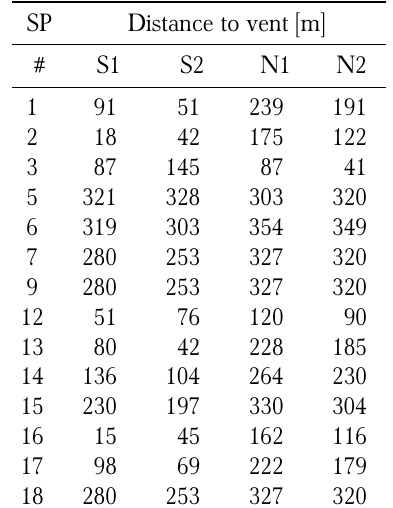
Table 1: Distance between sensor platforms and all the vents as of May 2019. The listed distances represent the line-of-sight accounting for horizontal and vertical differences. Distances were obtained by locating the sensor positions in a photogram- metric model of Stromboli’s crater